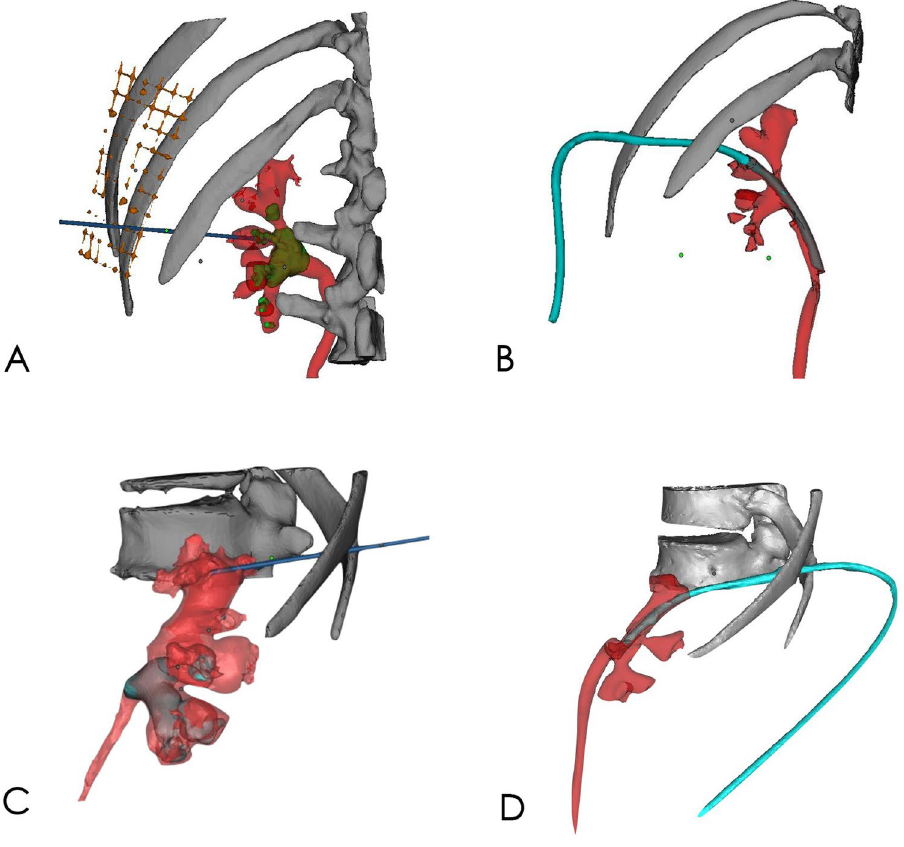
Figure 9. 3D visual model verifies that the puncture route passes precisely through the axis of the targeted renal calyx. ( A , C ) Preoperative 3D visual model of the renal collecting system, renal calculi, and the axial of the targeted renal calyx. ( B , D ) Postoperative 3D visual model shows that the puncture route passed precisely through the axis of the targeted renal calyx, which was highly consistent with that of the simulated axis of the targeted renal calyx before the operation. The figure was created with Mimics 19.0 (https:// www. mater ialise. com).